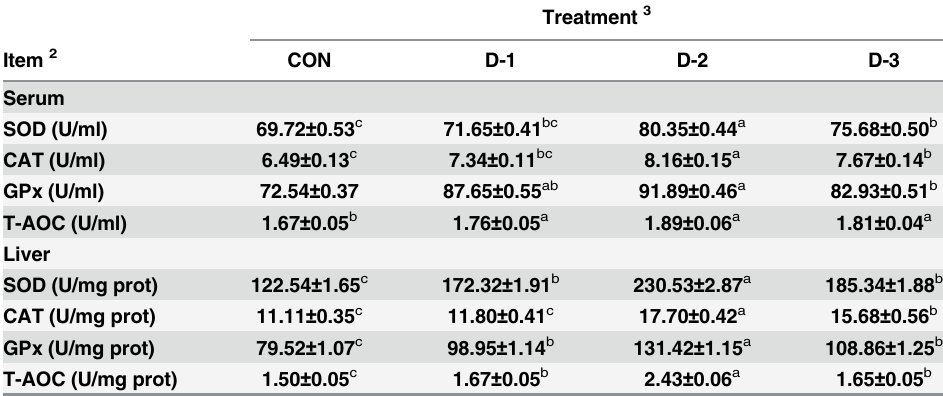
Table 3. Effects of DMG-Na on antioxidant system in mice serum and liver 1